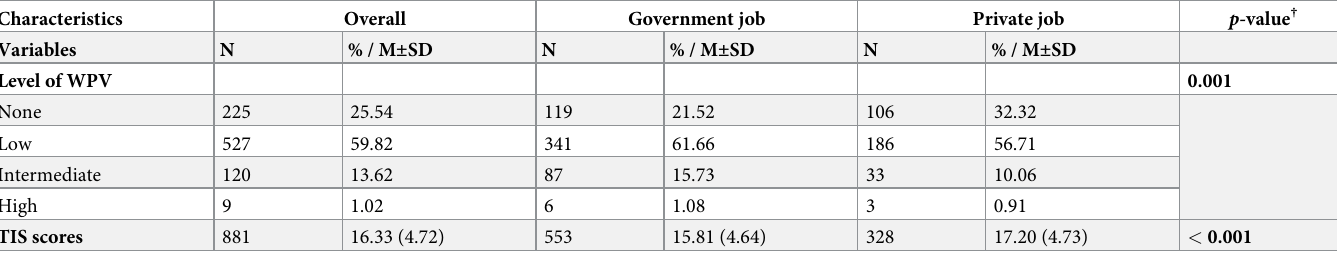
Table 2. Level of workplace violence among nurses and TIS scores (n = 881).